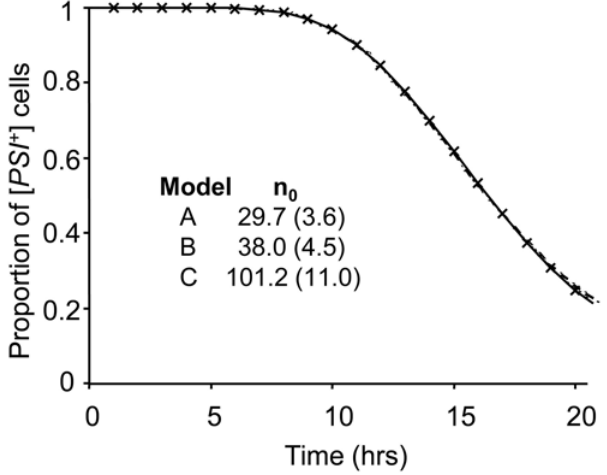
Figure 1. Simulation showing the proportion of [ PSI + ] cells against time following the addition of 3 mM GdnHCl to a dividing yeast culture. The data (denoted by X) are simulated by assuming that cells start with an average of n 0 =100 propagons per cell. The time that a mother cell takes to divide follows a gamma distribution with a mean of 2 hr and standard deviation 0.28 hr. The total time that a daughter cell takes to divide also follows a gamma distribution, but with means 3 hr and standard deviation 0.35 hr. The probability that a propagon passes to a daughter cell is assumed to be 0.3. Three different models are shown fitted to the data: 2?2?2? Model A [19]; - - - - Model B [21] and 2 Model C which gives an estimate of p =0.3 (with standard error 0.02). The value of n 0 estimated by each model is shown with standard errors in brackets.